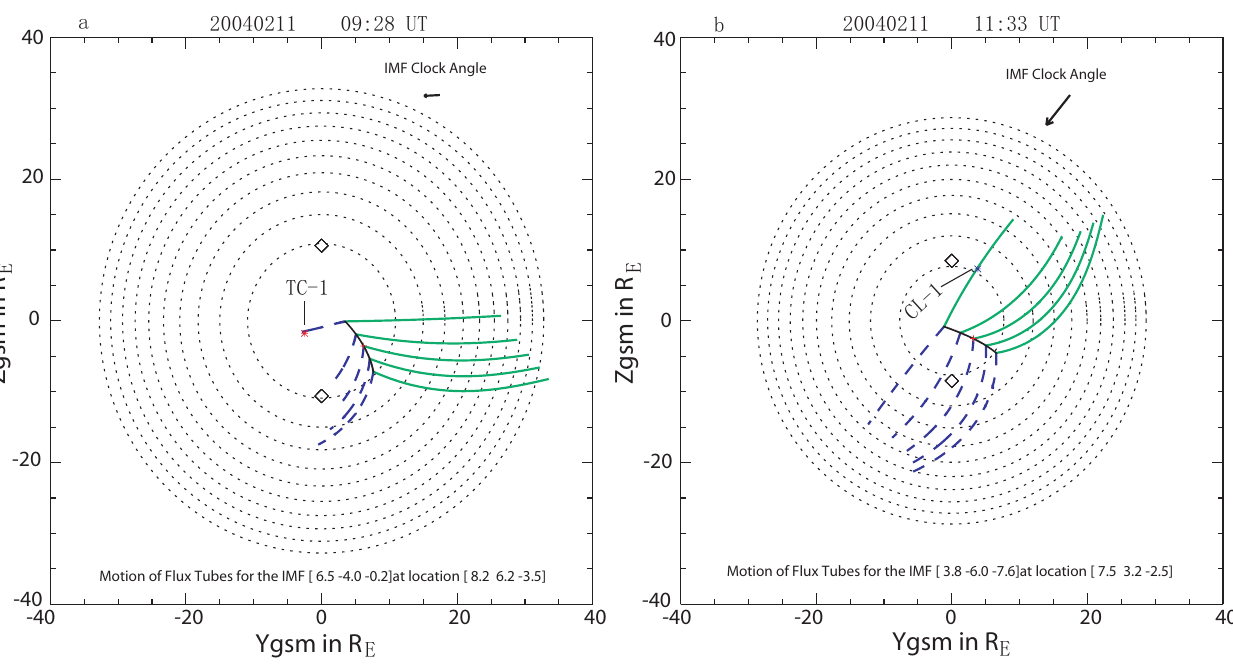
Fig. 9. Motion of reconnected flux tubes for low-latitude reconnection under IMF clock angle of (a) 85.63 ◦ and (b) 148.13 ◦ , respectively, which is obtained by running the Cooling model. The reconnection conditions are satisfied along a merging line, the projection of which is indicated by the black diagonal line in the middle of the figure. The solid lines indicate the trajectories of tubes which connect to the northern cusp, and the dashed lines indicate those which connect to the southern cusp. The position of Cluster and TC-1 was represented by the blue and red star dot, respectively. Table 1. Cataloge of Cluster FTE motion for the FTEs marked in Fig. 3, and the expected motion of the flux tubes by running the Cooling model and the angle between the expected velocities and the Cluster observations, together with the expected motion for the two FTEs measured by TC-1. The directions ( n ) and the speeds ( | V | ) of the motion are obtained from four-spacecraft techniques, and the size of each flux tube observed by Cluster was estimated by using the velocity and the duration of the whole bipolar signature of each